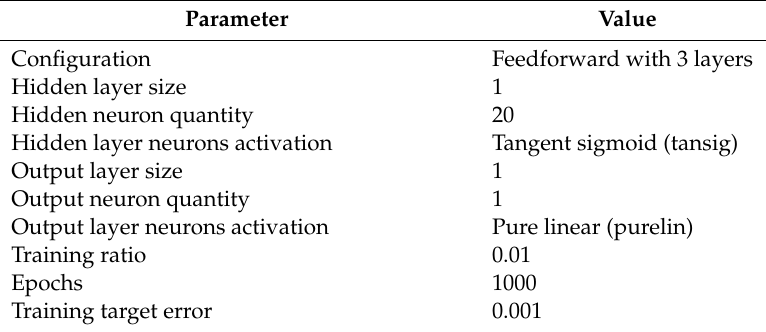
Table 1. Parameters of